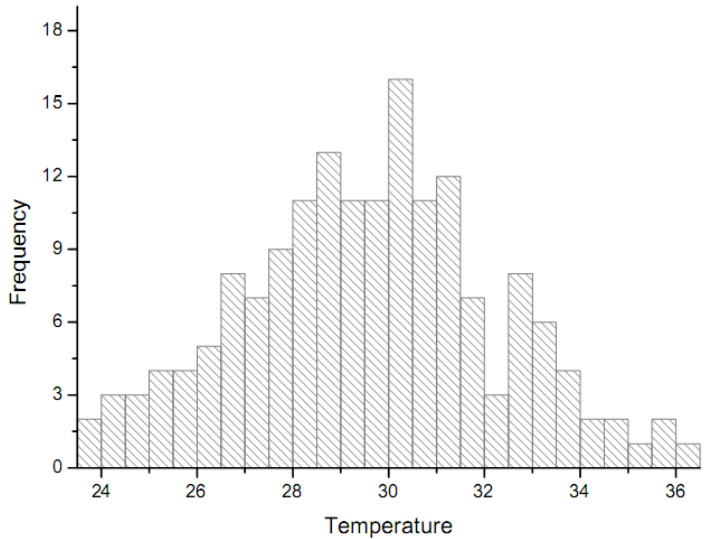
Figure 2. Histogram and simulated pdf of the normal distribution for the temperature dataset (in ºC). The dataset belongs to a normal distribution with mean m = 26.68 ºC and std deviation σ = 1.403